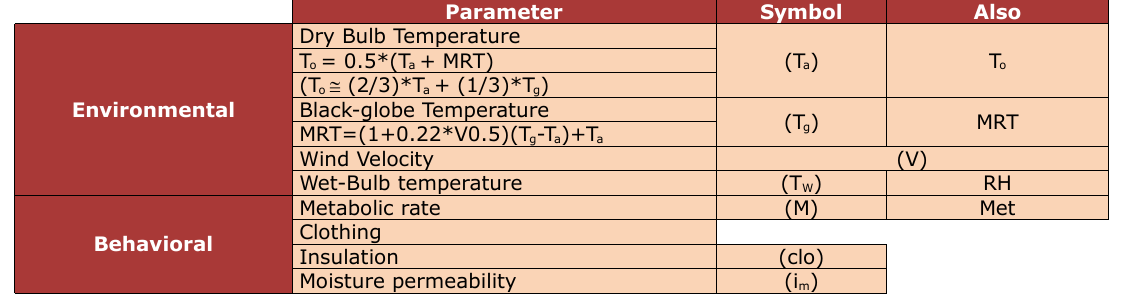
Table 2. Key Heat